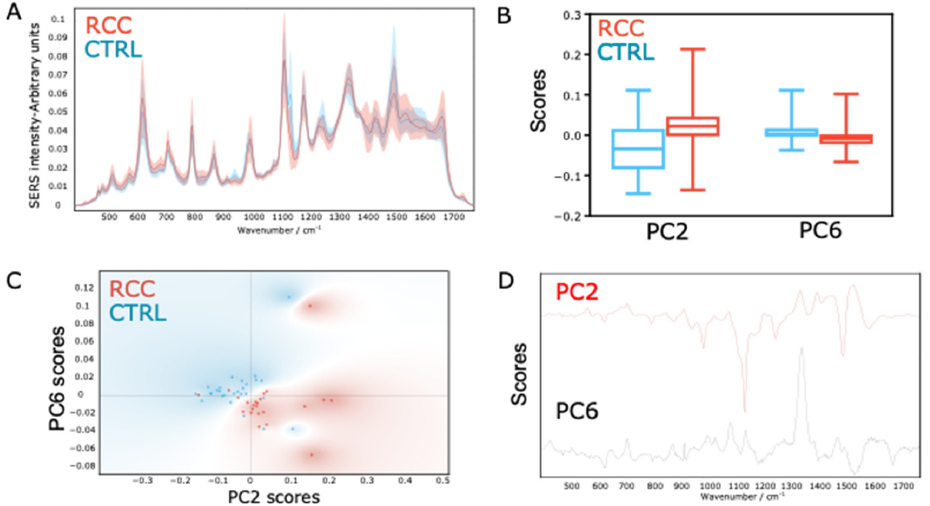
Figure 1. ( A ) The average SERS spectra of serum from renal cell carcinoma (RCC) versus control (CTRL) patients. ( B ) The distribution of score values for principal component (PC) 2 and PC6 of RCC (red) and CTRL (blue) patients. ( C ) Score plots of PC2 and PC6 for RCC (red) and CTRL (blue) patients. ( D ) Loading plots of PC2 and